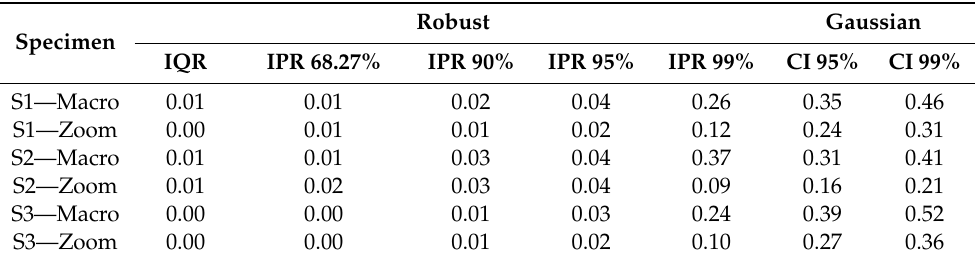
Table 7. Robust interpercentile ranges (IPR) and Gaussian confidence intervals (CI) for the pre-calibration / self-calibration comparison. Units: millimeters.